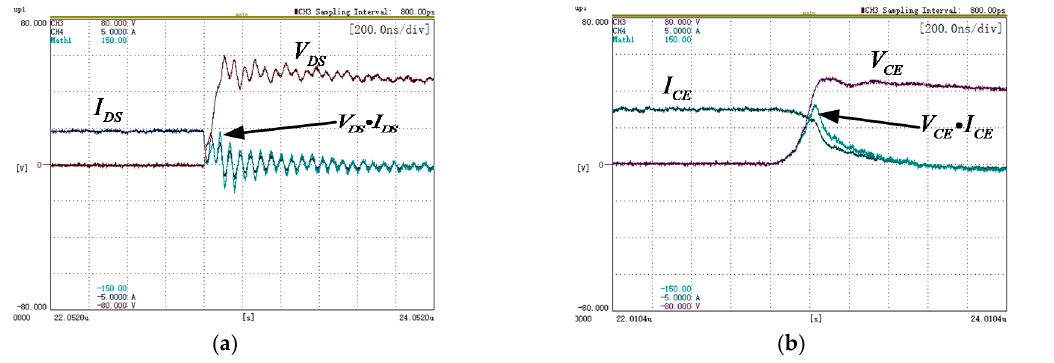
Figure 11. Turn-off loss test waveform. ( a ) GaN, ( b ) IGBT. Energies 2019 , 12 , x FOR PEER REVIEW